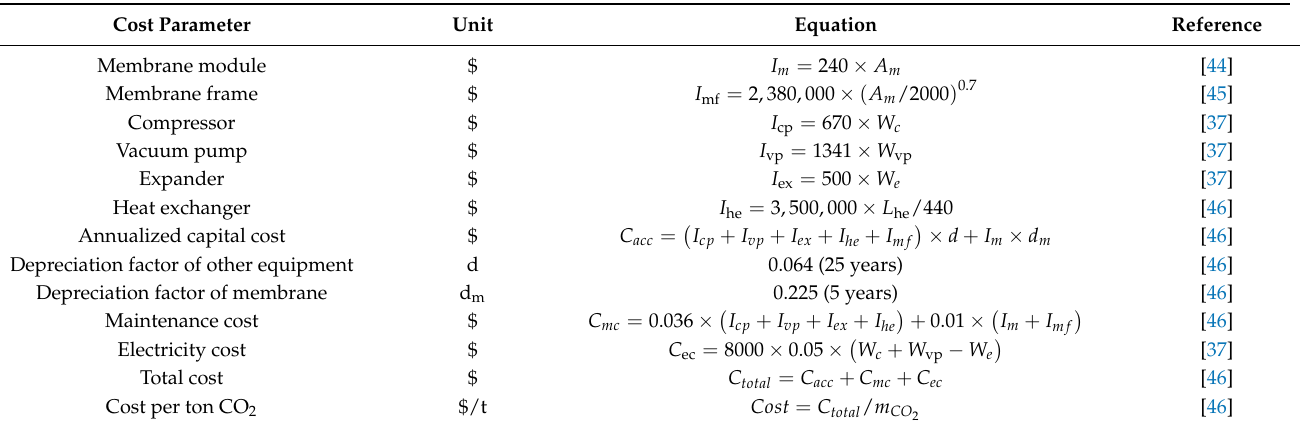
Table 3. Economic calculation